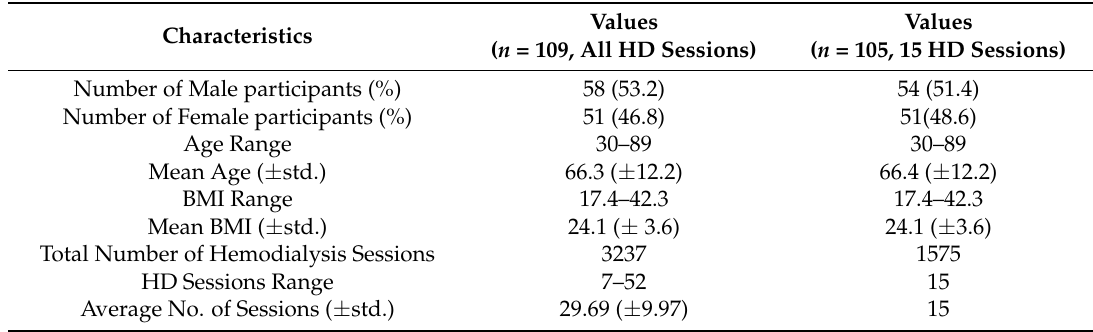
Table 1. Baseline characteristics of the study data ( n = number of patients).